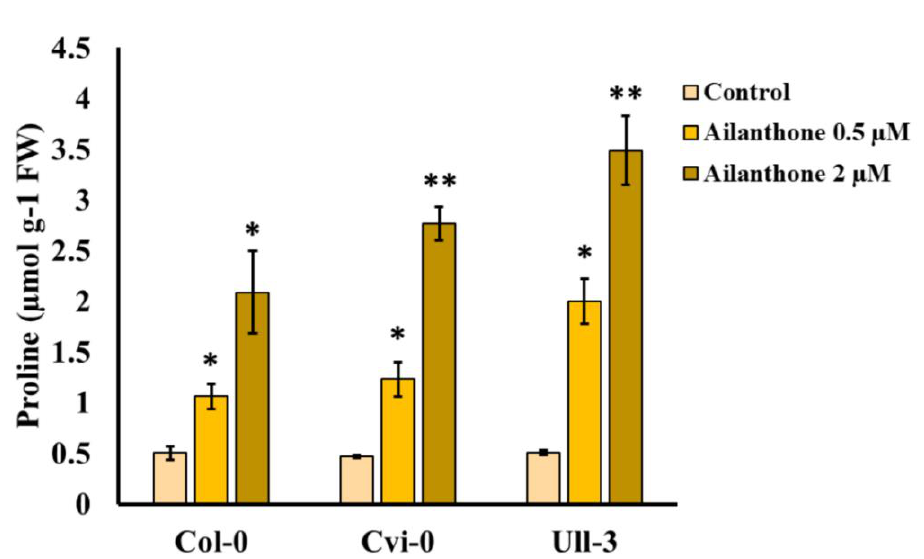
Figure 4. Ailanthone treatment induces proline content. Quantifying proline content in 12-day-old MS-grown Col-0, Cvi-0, and U112-3 seedlings shifted to the MS medium supplemented with mock (control), 0.5 and 2 µ M ailanthone for 1 week. Sample number, n = 3; error bars, SD; * indicates p < 0.05, ** indicates p < 0.01 (unpaired Student’s t -test).